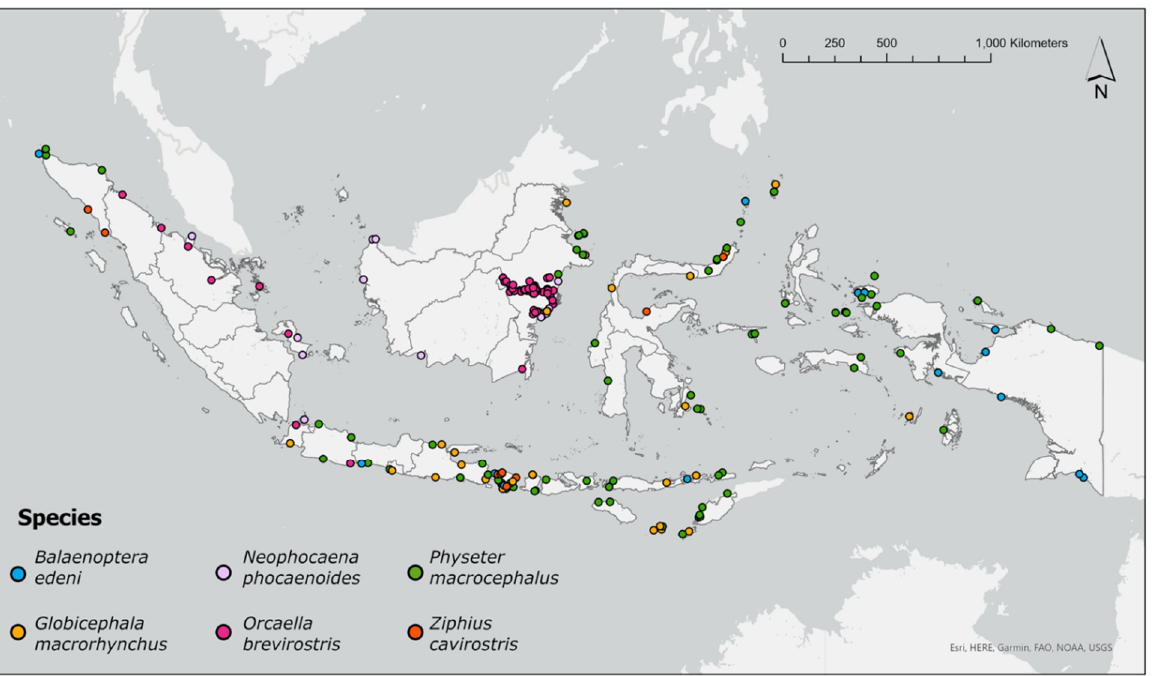
Figure 4. Species-specific cetacean strandings of six species in Indonesia 1995–2021. The stranding distributions of other species are available in the http://www.whalestrandingindonesia.com/map.html (accessed on 1 February 2022).